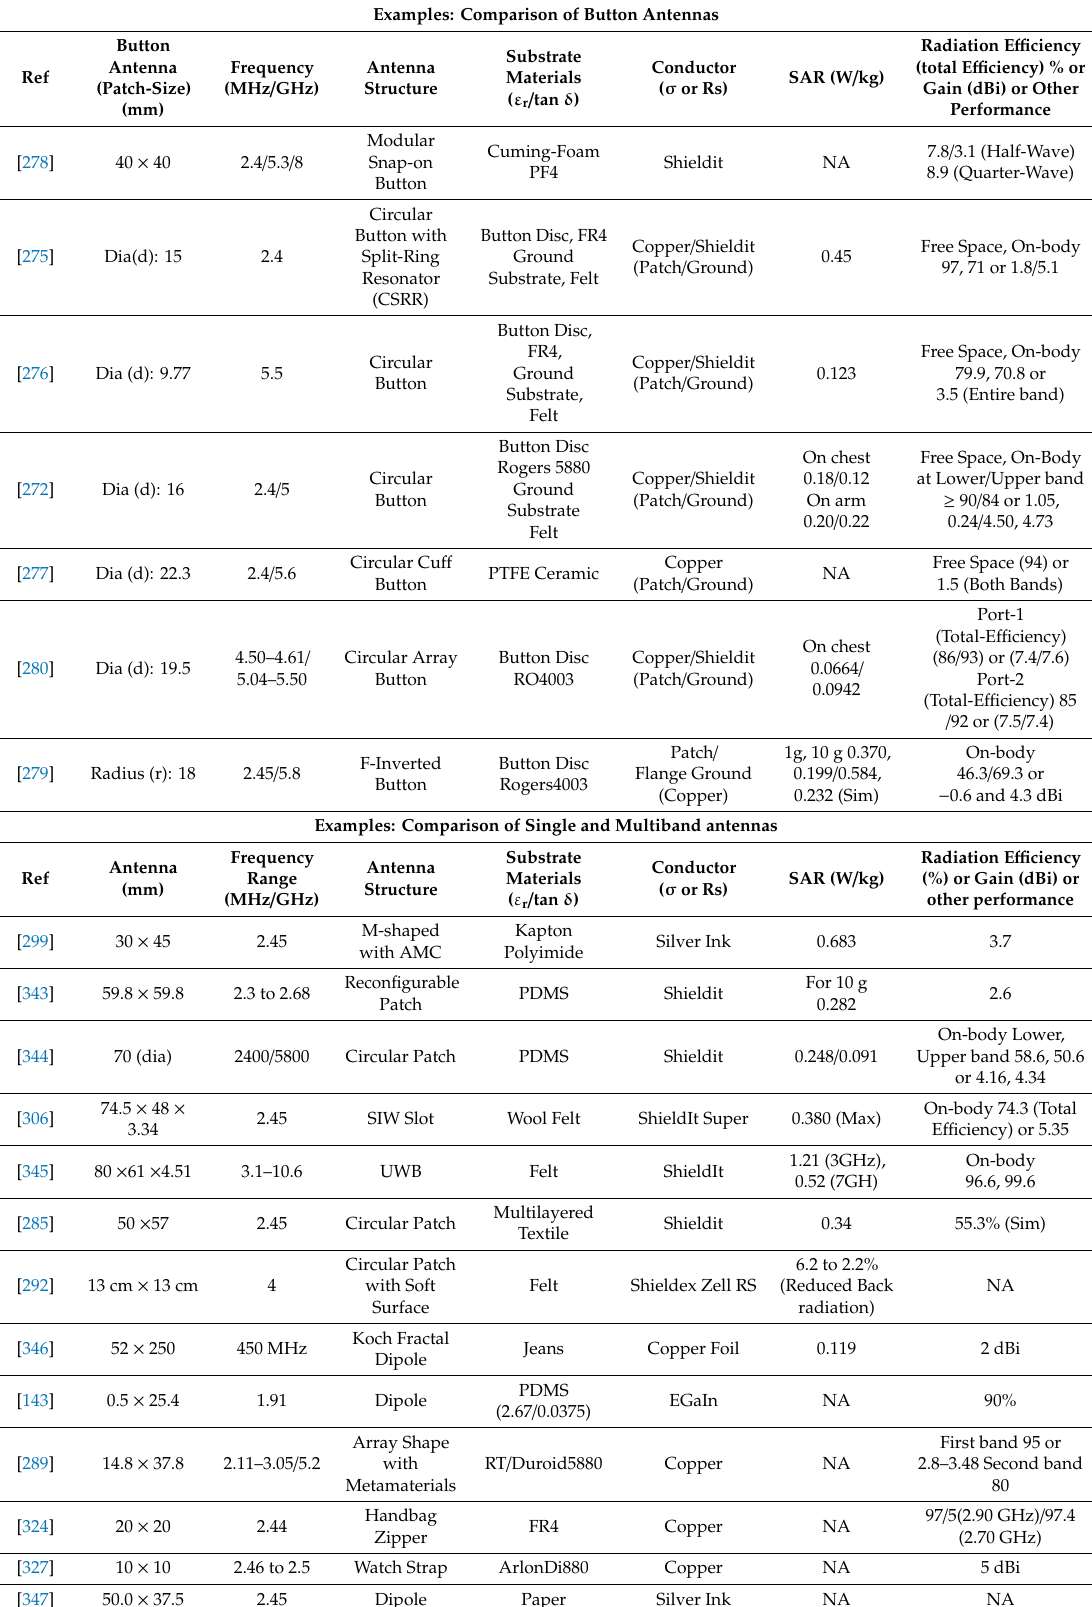
Table 10. Comparison of di ff erent wearable